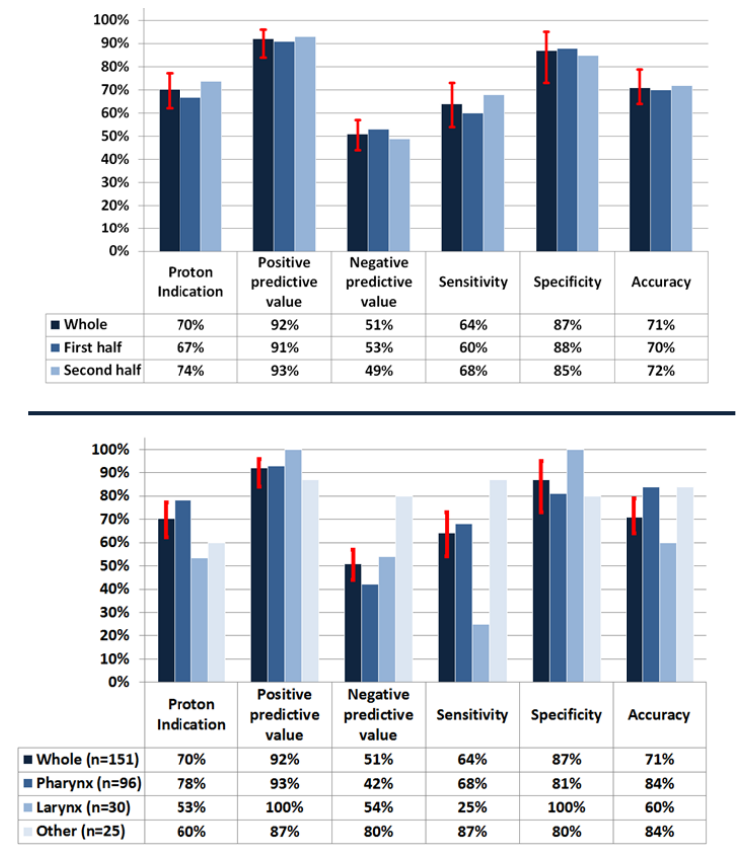
Figure 6. Variability of diagnostic measures across split cohort groups ( upper ) and across tumor locations ( lower ). The red bars on the columns of the whole patient cohort indicate 95% CI of the decision support tool.